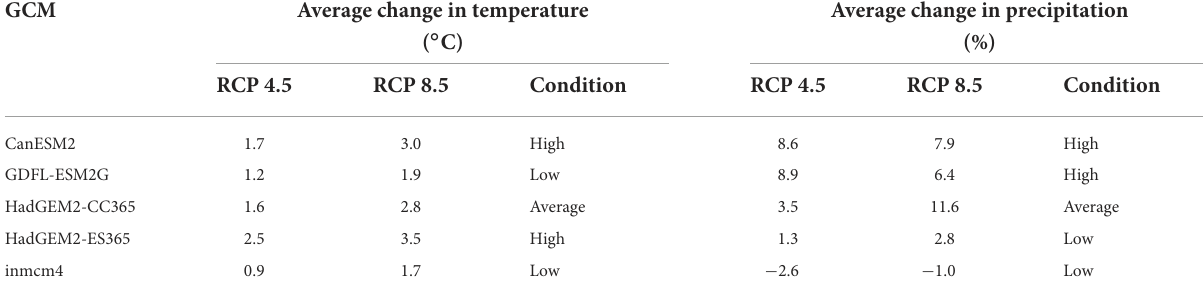
TABLE 1 The average projected change in temperature and precipitation for the five selected GCMS associated with RCP 4.5 and RCP 8.5 (Malek et al., 2018b). GCM Average change in